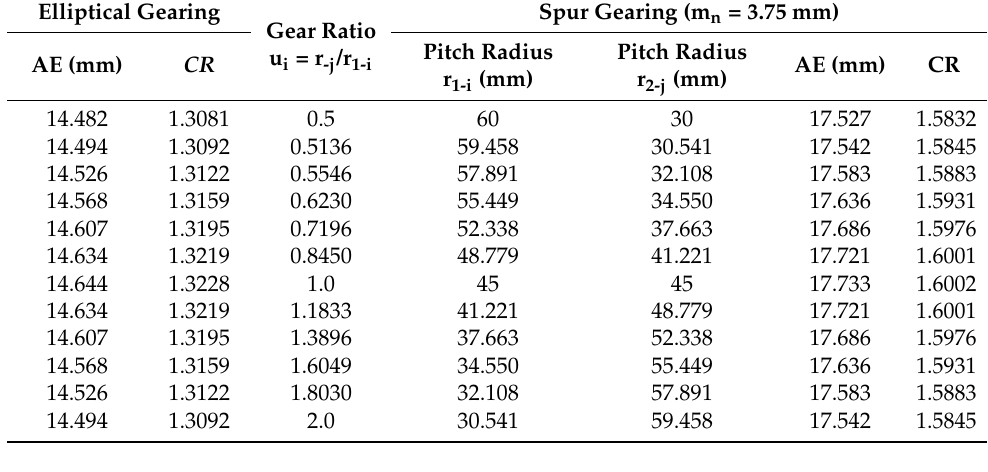
Table 2. Length of part of contact AE and contact ratio.